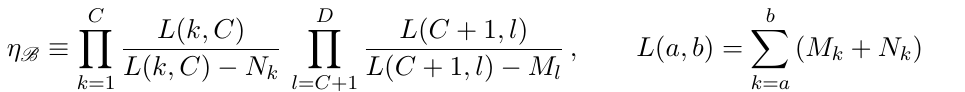
( N c ), and N i = N c . i O P